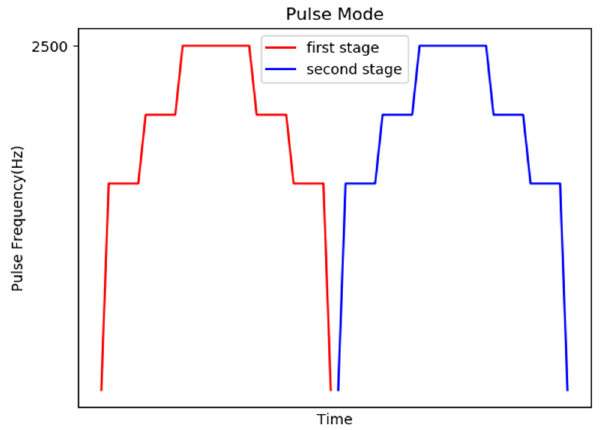
Figure 16. Schematic diagram of the second control mechanism.